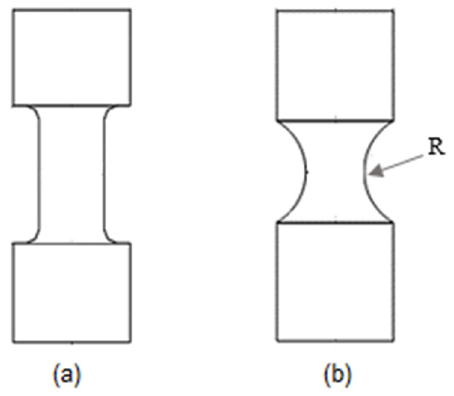
Figure 4. ( a ) Smooth sheet specimen; ( b ) Notched sheet specimens.